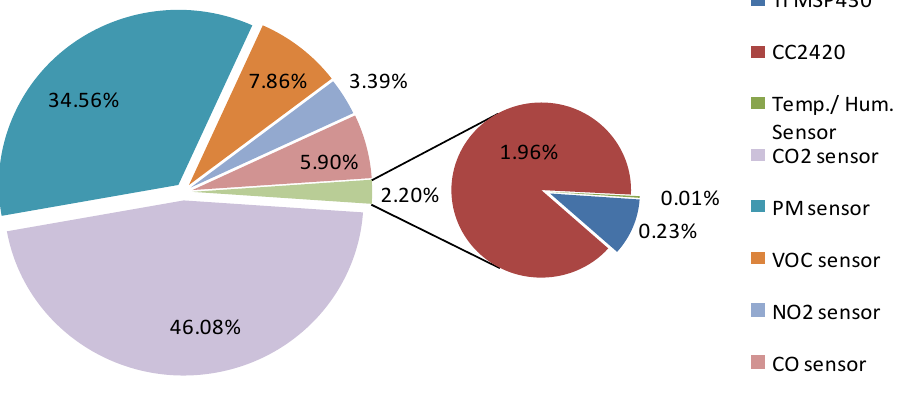
Figure 3. Power consumption breakdown for the sensor board and the base